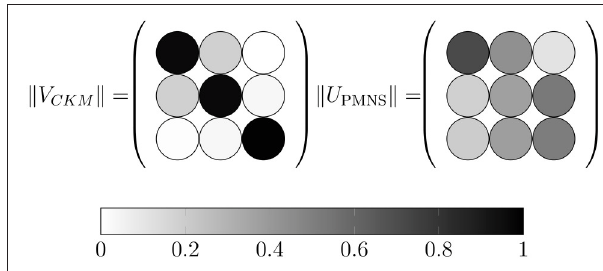
FIGURE 1 | Pictorial representation of the absolute values of the matrix elements of the V CKM and U PMNS